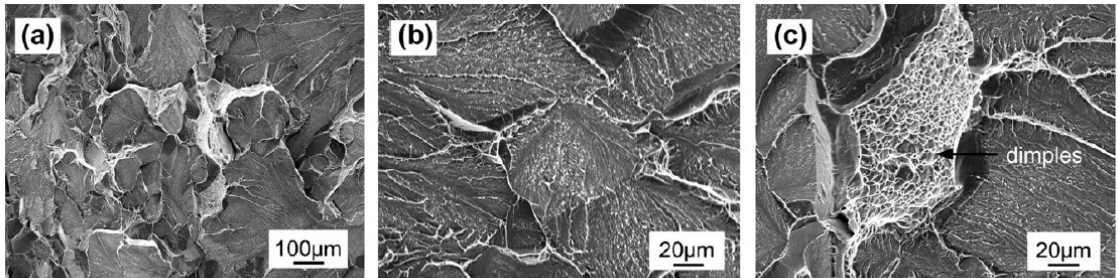
Figure 12. SEM fractograph of the joint after tensile test at room temperature: ( a ) over view; ( b ) cleavage planes and ( c ) ductile dimples in the cleavage steps. (Reprinted with permission from [105]. Copyright 2013